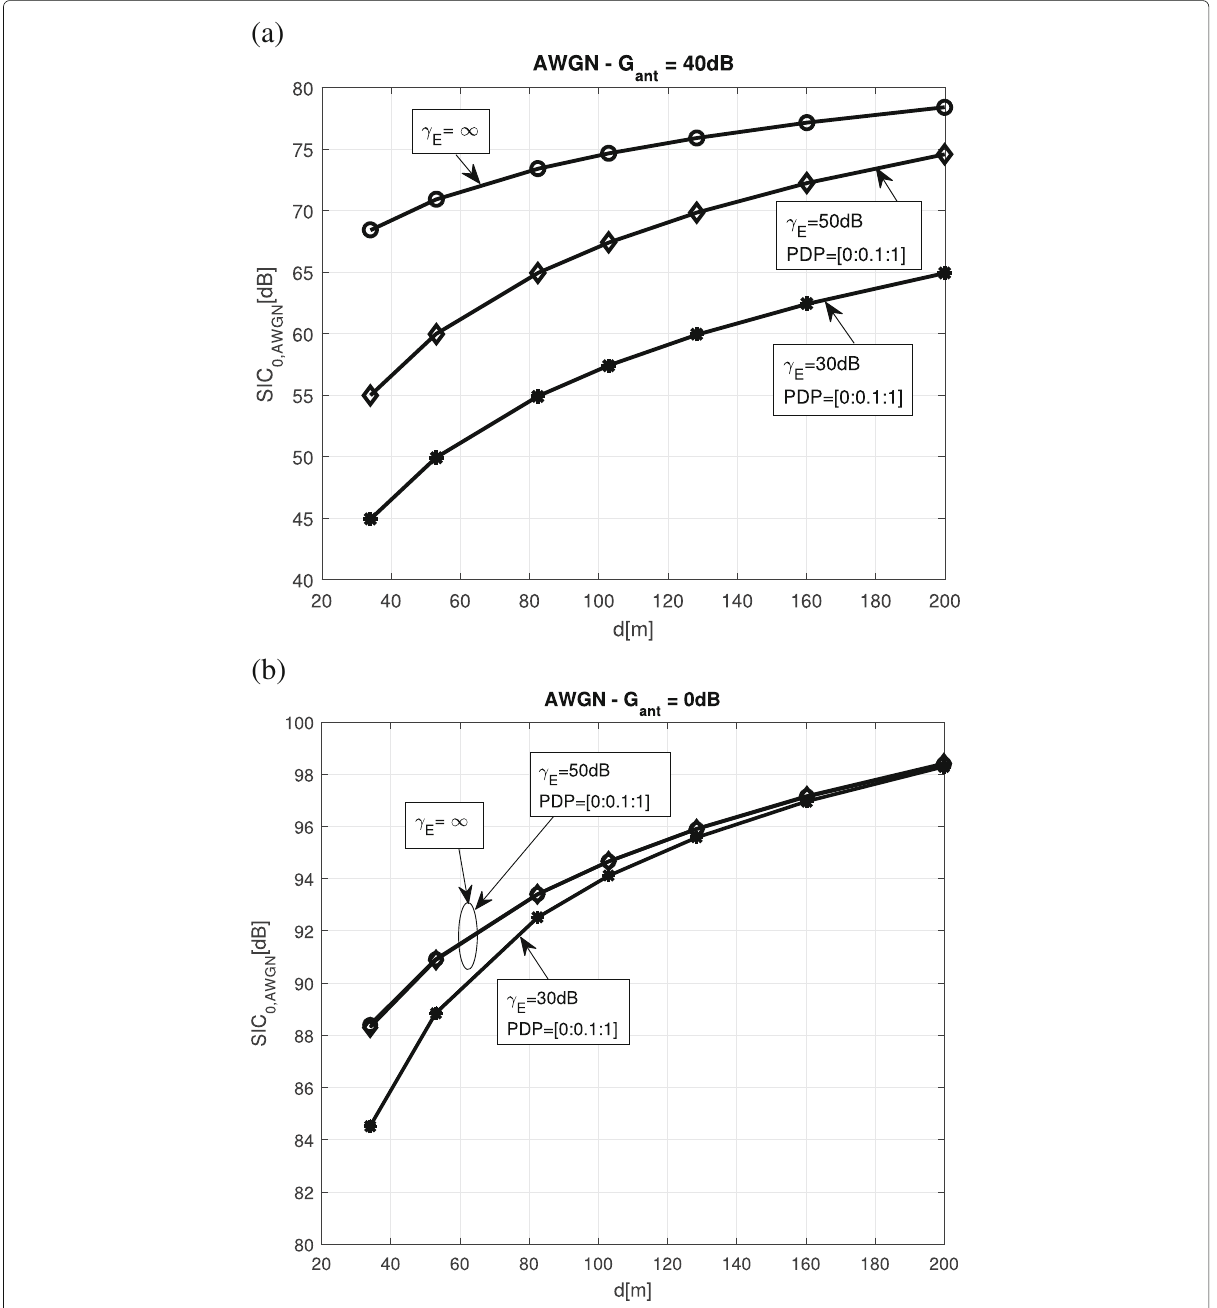
Fig. 2 SIC threshold SIC 0,AWGN for two different values of G ant . Threshold SIC 0,AWGN [dB] vs. distance d for two different values of G ant , G ant = 40 dB ( a ) and G ant = 0 dB ( b ). Each sub-figure shows the curves for values of parameter γ E = [ ∞ ,10 5 ,10 3 ] and PDP = [0 : 0.1 : 1]